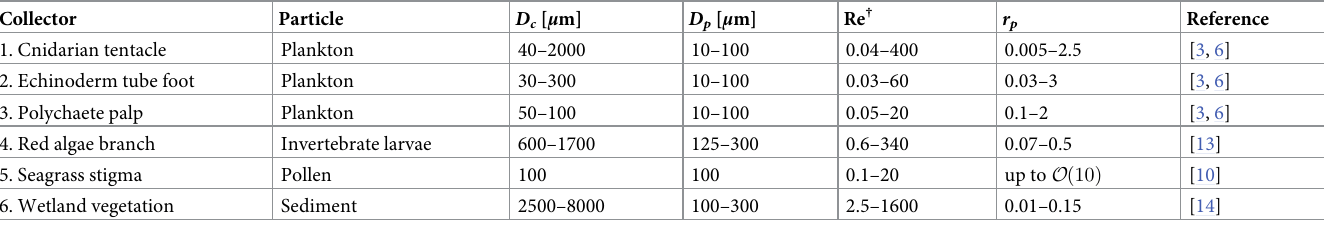
Table 2. Typical values of dimensionless parameters Re and r p in aquatic ecosystems where particle capture is a fundamentally-important process.